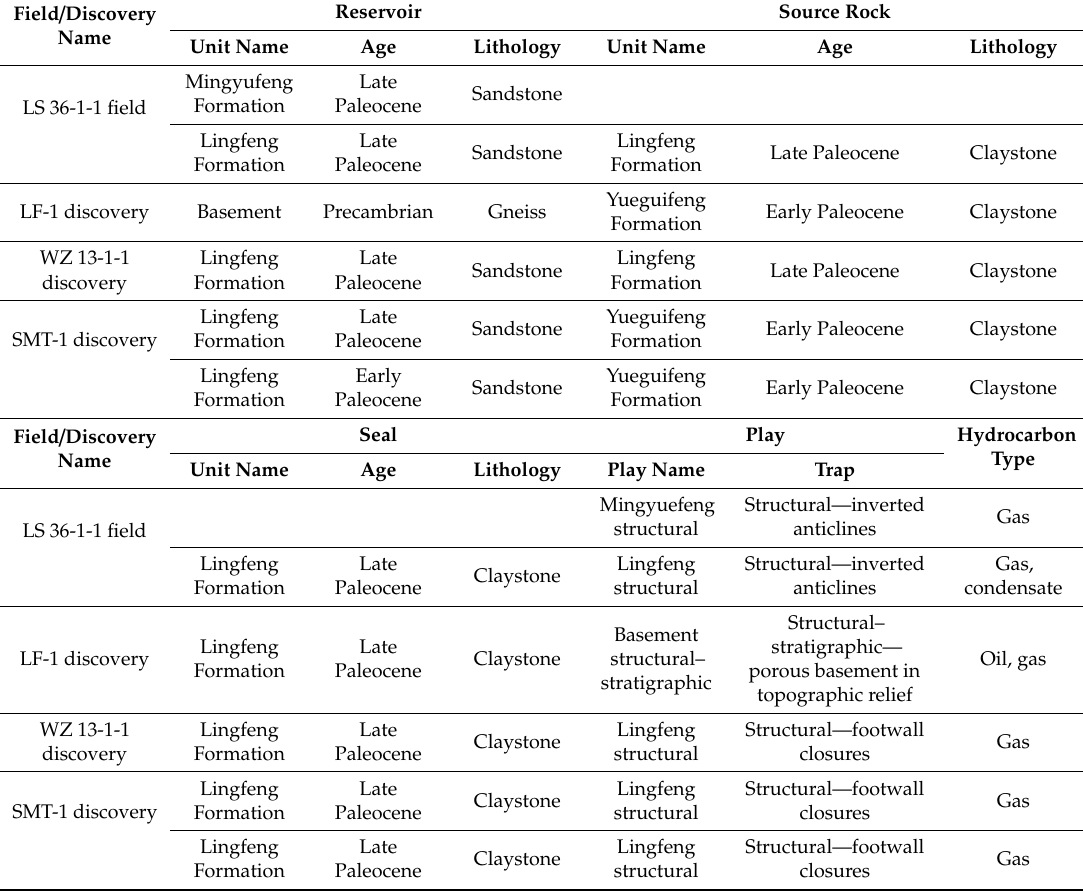
Table 3. Summary of hydrocarbon fields and discoveries of the Lishui Sub-basin.